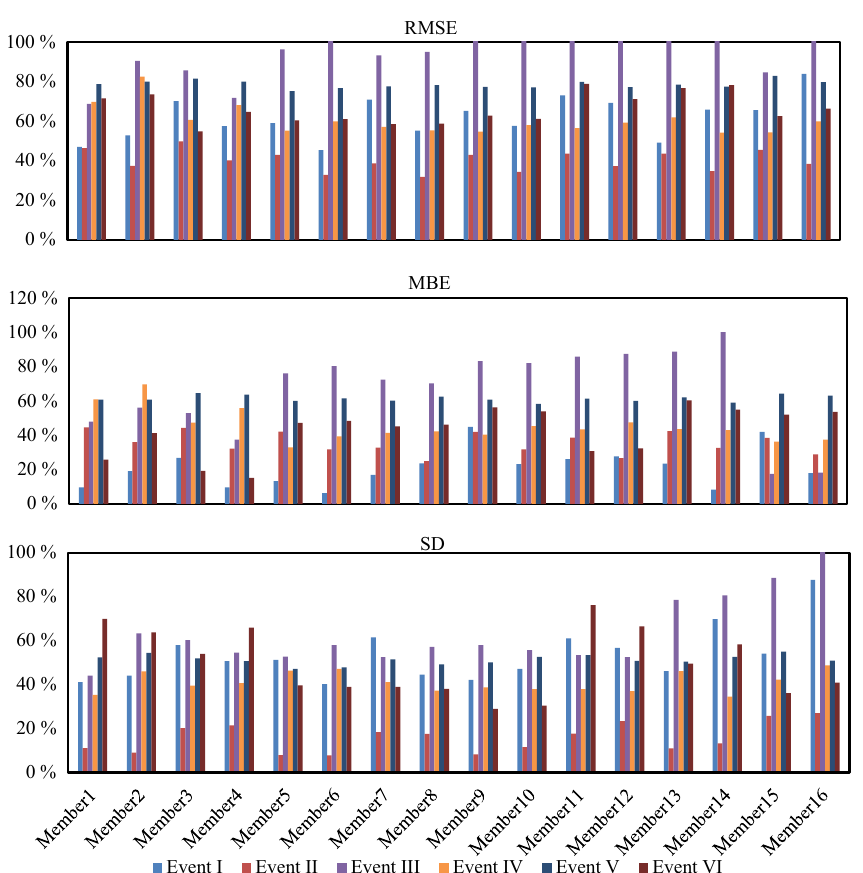
Figure 5. Spatial values of the three continuous indices for different storm events with the 16 members of the physical ensemble.